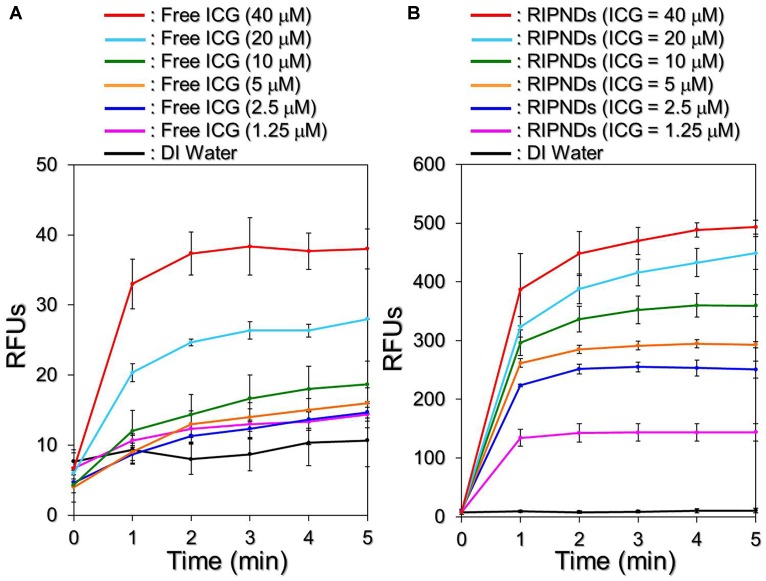
Assessments of ICG solution- and RIPND-induced singlet oxygen productions under NIR exposure. Upon NIR laser irradiation (808 nm; 6 W/cm2), the amount of singlet oxygen generated from the freely dissolved ICG in DI water (A) and RIPNDs (B) with equal ICG concentration settings of 0, 1.25, 2.5, 5, 10, 20, and 40 μM were separately measured every 1 min for 5 min. The quantity of singlet oxygen in each sample was analyzed based on the SOSG-induced fluorescence intensity measured by using a spectrofluorometer with 488-nm excitation wavelength and 525-nm emission wavelength, and was quantitatively represented by RFUs. Values are mean ± s.d. (n = 3).